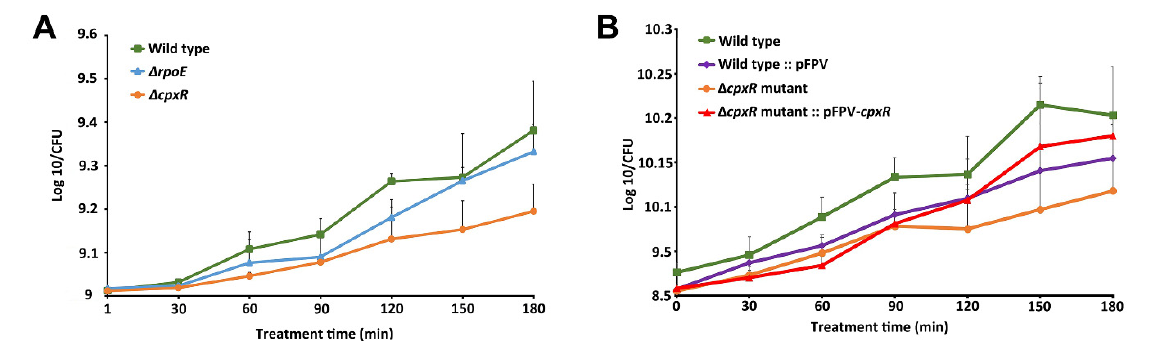
Figure 3. Chlorhexidine killing assay. ( A ) The effect of MIC (3 µg/mL of CHX) on ∆ rpoE and ∆ cpxR mutant S. Enteritidis strains compared with the wild-type over the exponential growth phase. ( B ) The effect of the cpxR deletion on the susceptibility of S. Enteritidis to chlorhexidine as well as the susceptibility of respective complemented strains.